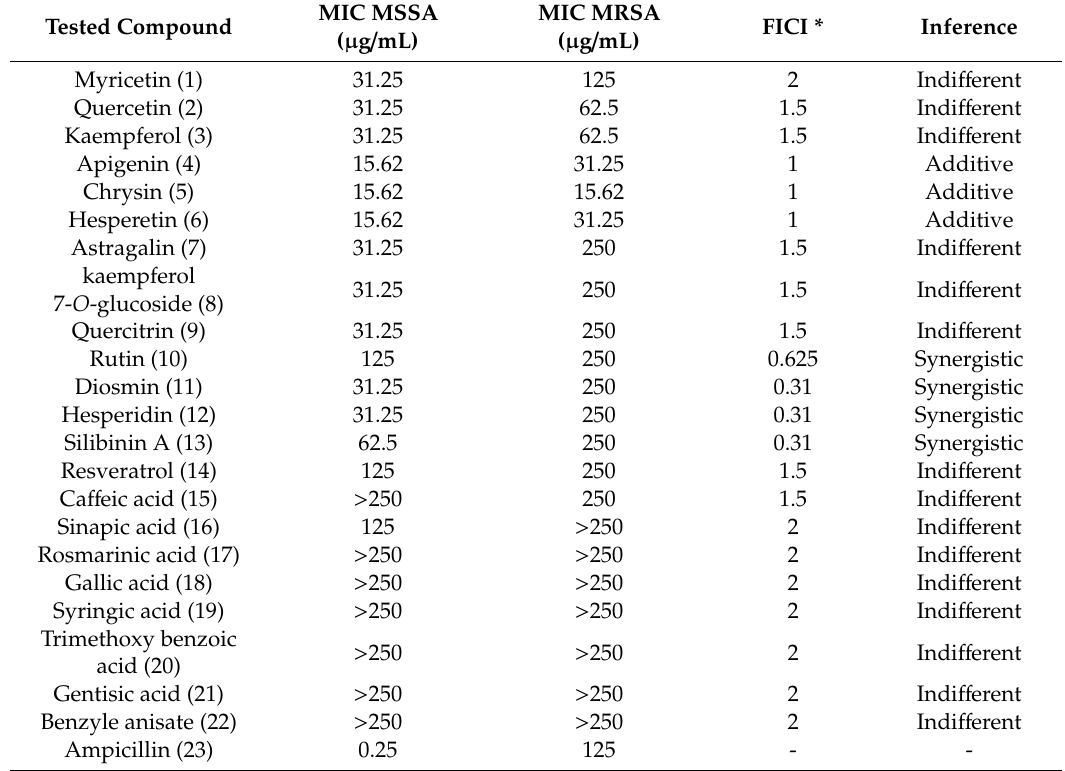
Table 2. Inhibitory activity of the tested compounds alone and in combination with ampicillin against both MSSA and MRSA.